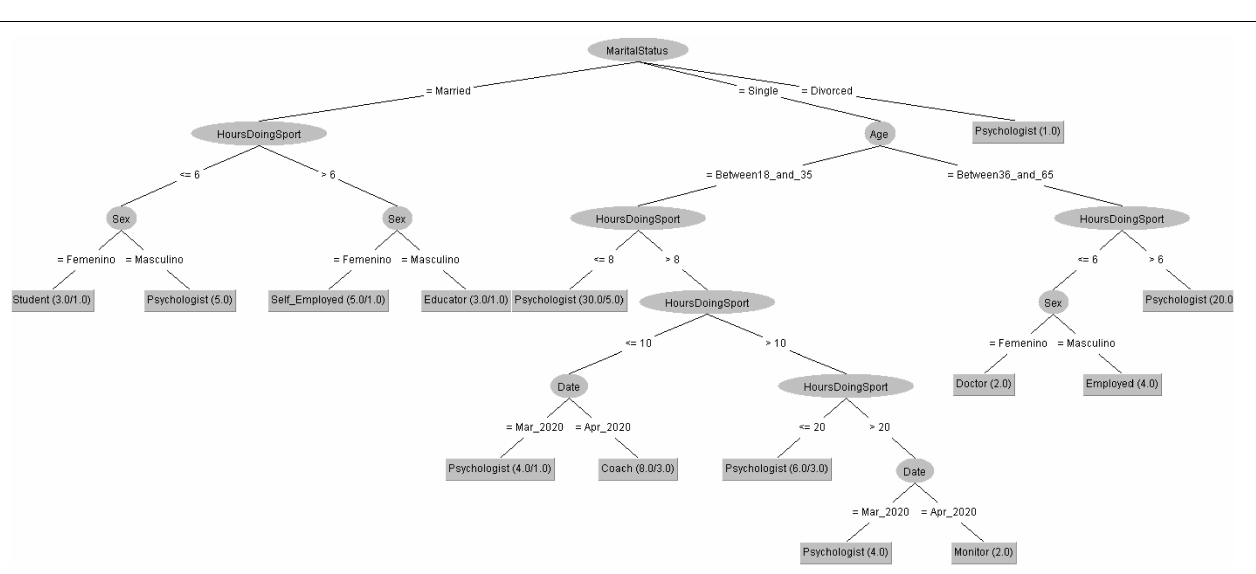
FIGURE 18 | Profession of people taking the AF5 questionnaire in 2020 decision